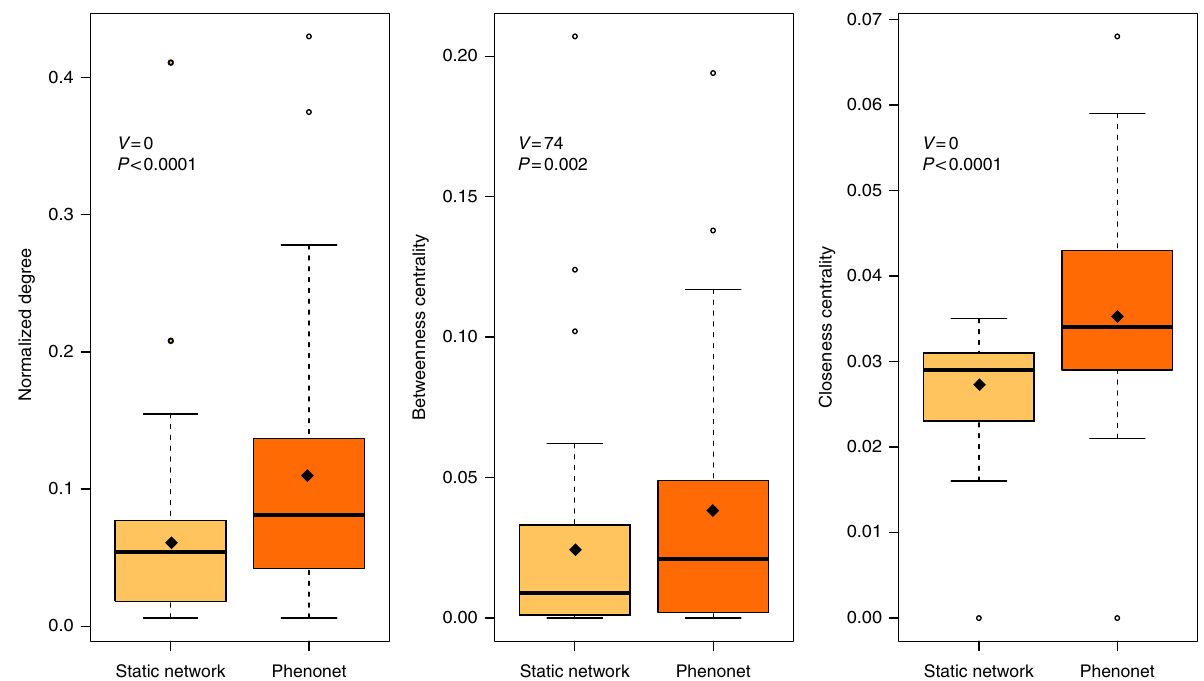
Fig. 3 Plant species ’ behaviour as estimated in their phenonets vs. the static network. The three species-level network properties tested are the Normalized Degree (ND), Betweenness Centrality (BC) and Closeness Centrality (CC) of the study plants (for details, see Methods). Statistical signi fi cance was assessed with paired Wilcoxon signed-rank tests ( N =